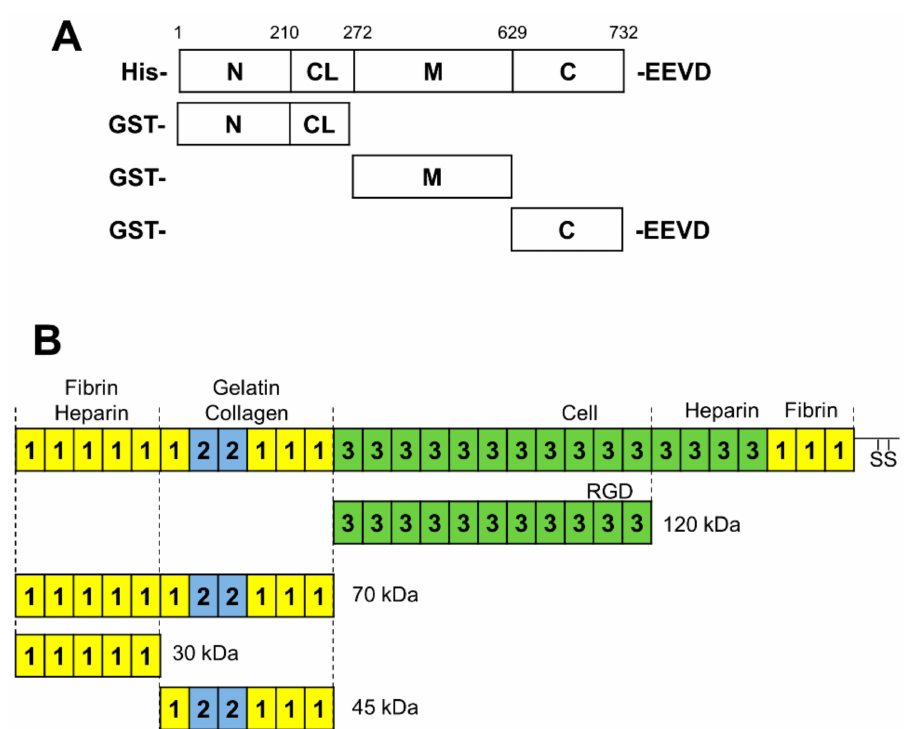
Figure 1. Schematic diagram of HSP90 and fibronectin (FN) domains. ( A ) HSP90 domain boundaries indicated by numbering and recombinant fragments used in this study. ( B ) Domain structure of full-length fibronectin and proteolytic fragments thereof. The squares labeled 1, 2, and 3 refer to the type-I, type-II, and type-III FN domains, respectively. The binding sites of FN interactors are labeled above, while the sites of proteolytic cleavage of full-length FN are indicated by dotted lines and they give rise to the smaller 120, 70, 45, and 30 kDa fragments used in this